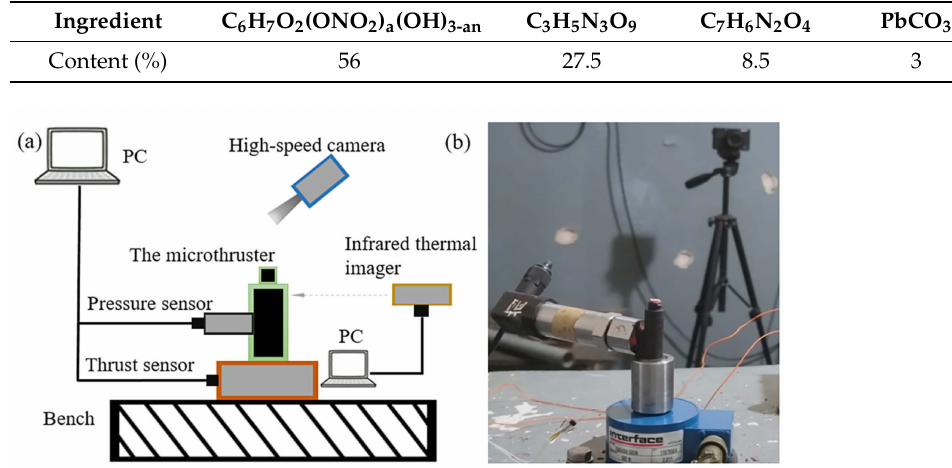
Table 3. SG-2 propellant’s main formulations.